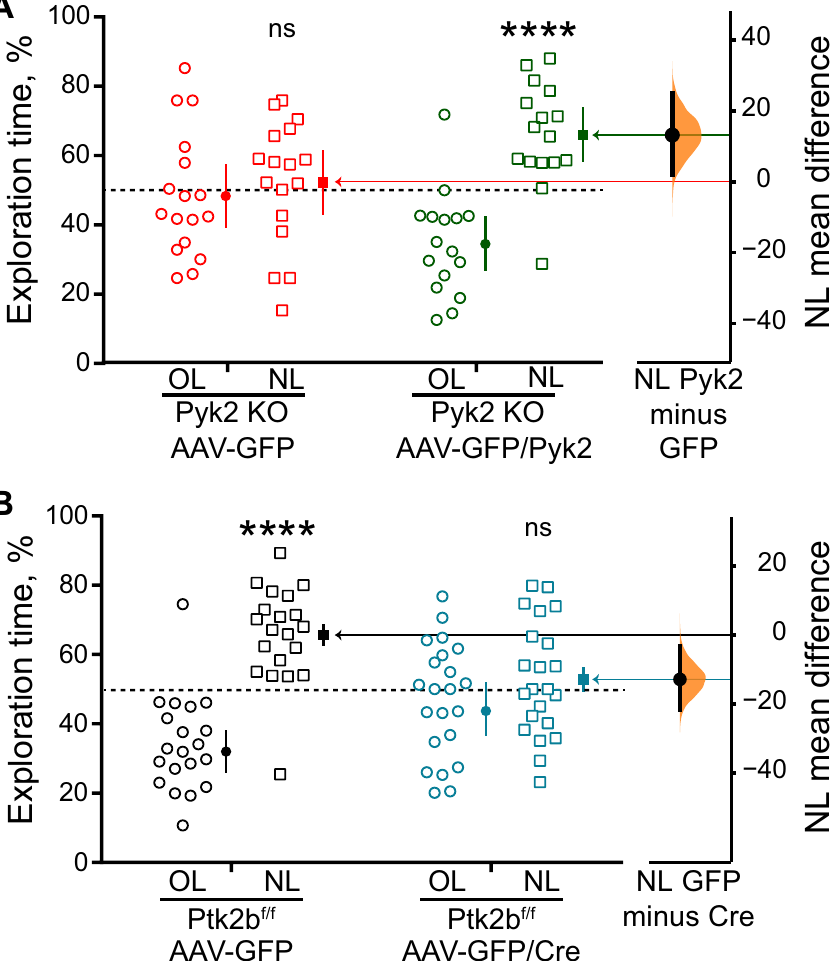
Figure 2. The deficit in NOL in Pyk2 KO mice is rescued by re-expression of Pyk2 in the dorsal hippocampus and mimicked by its selective deletion in this region. ( A ) Pyk2 re-expression rescues NOL. Pyk2 KO male mice were injected bilaterally in dorsal hippocampus CA1 with AAV-GFP (n = 17) or AAV-GFP/Pyk2 (n = 16). Three weeks later their performance in the NOL test was evaluated and plotted as in Fig. 1. The time spent exploring the object at NL for AAV-GFP-injected mice was not different from random choice for KO AAV-GFP-injected mice (one-sample t-test NL exploration time vs. 50% chance preference, t 16 = 0.45, p = 0.66), whereas it was for KO AAV-GFP/Pyk2-injected mice (t 15 = 4.22, p = 0.0008). Comparison of NL KO AAV-GFP vs KO AAV-GFP/ Pyk2, unpaired two-tailed t test with Welch’s correction, t 30 = 2.40, p = 0.02. Mean difference in time spent exploring NL between AAV-GFP and AAV-GFP/Pyk2 plotted as in Fig. 1B, two-sided permutation t-test, p = 0.024. ( B ) Targeted conditional deletion of Pyk2 in dorsal hippocampus CA1 alters NOL. Pyk2 f/f male mice injected bilaterally with either AAV-GFP (n = 20) or AAV-GFP/Cre (n = 22) were tested for NOL 3 weeks later. One-sample t-test (NL exploration time vs. 50% chance preference) AAV-GFP-injected mice, t 19 = 5.11, p < 10 –4 , AAV-GFP/Cre-injected mice, t 21 = 0.84, p = 0.41. Mean difference in time spent exploring NL between AAV-GFP and AAV-GFP/Cre plotted as in Fig. 1B, two-sided permutation t-test, p = 0.0092. In ( A ) and ( B ), the horizontal dotted line indicates the chance level (50%), bars indicate means + SEM, *, p < 0.05, **** p < 10 –4 , ns, not significant. Statistical results in Supplementary Table